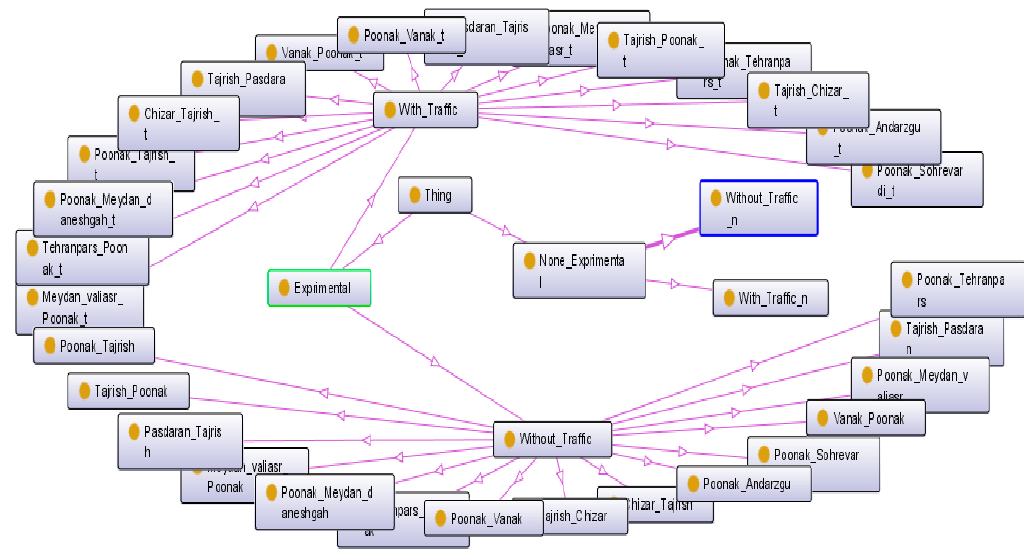
Figure 1. Driver’s experience ontology.